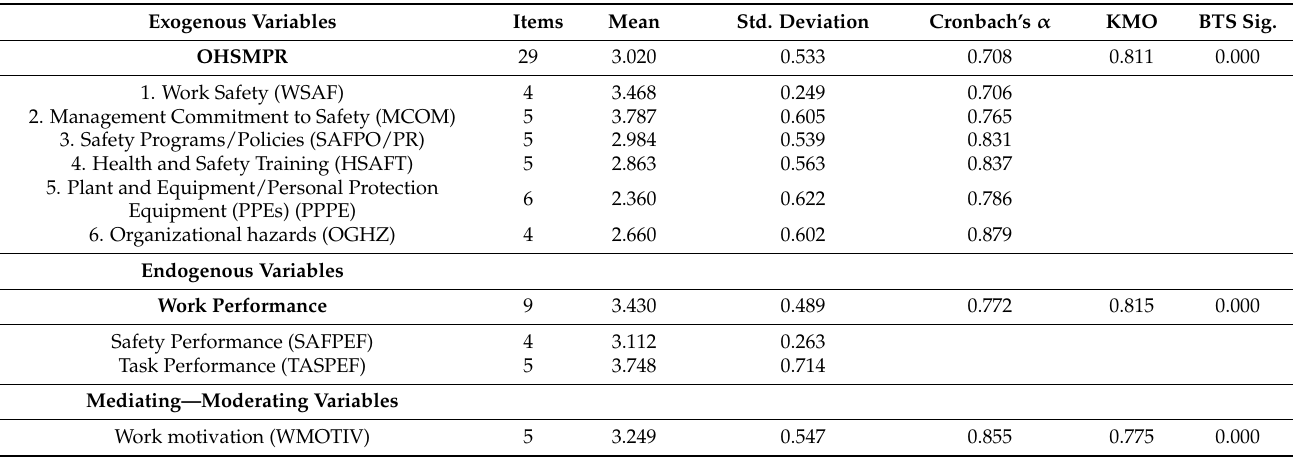
Table 4. Results for Reliability